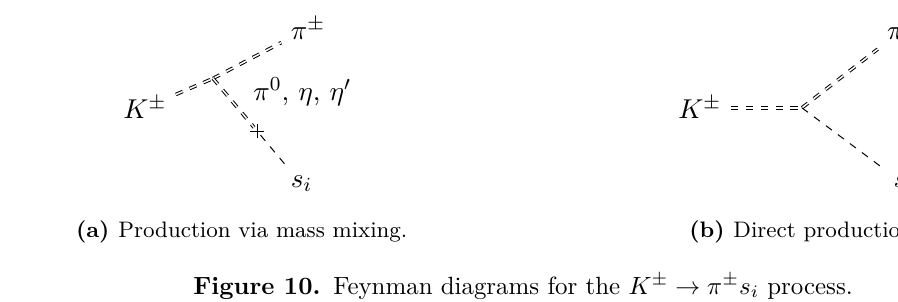
Figure 10. Feynman diagrams for the K ± → π ± s i